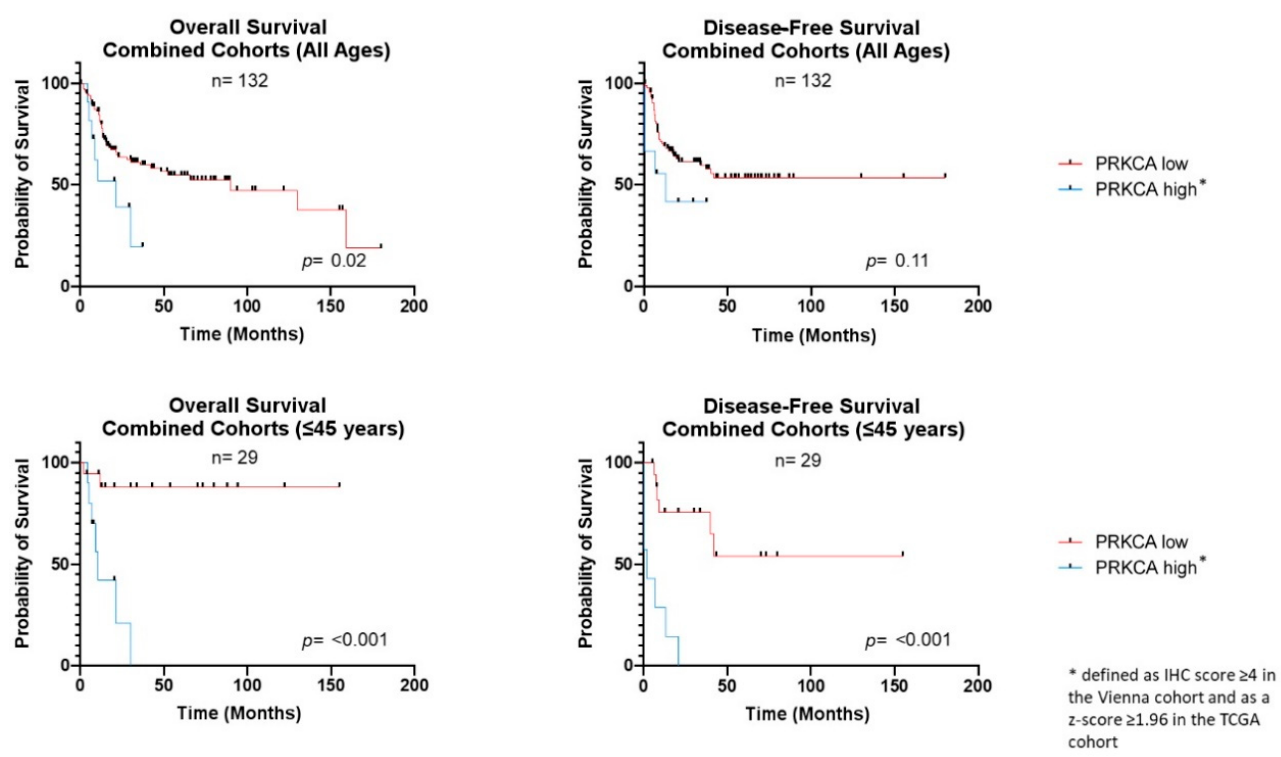
Figure 2. Kaplan–Meier survival curves in correlation to PRKCA expression levels. Univariate survival analysis shows significantly reduced OS of OTSCC patients with high PRKCA expression ( p = 0.02). In the subgroup of patients aged 45 years or younger, high PRKCA expression compromises both OS and DFS (each p <